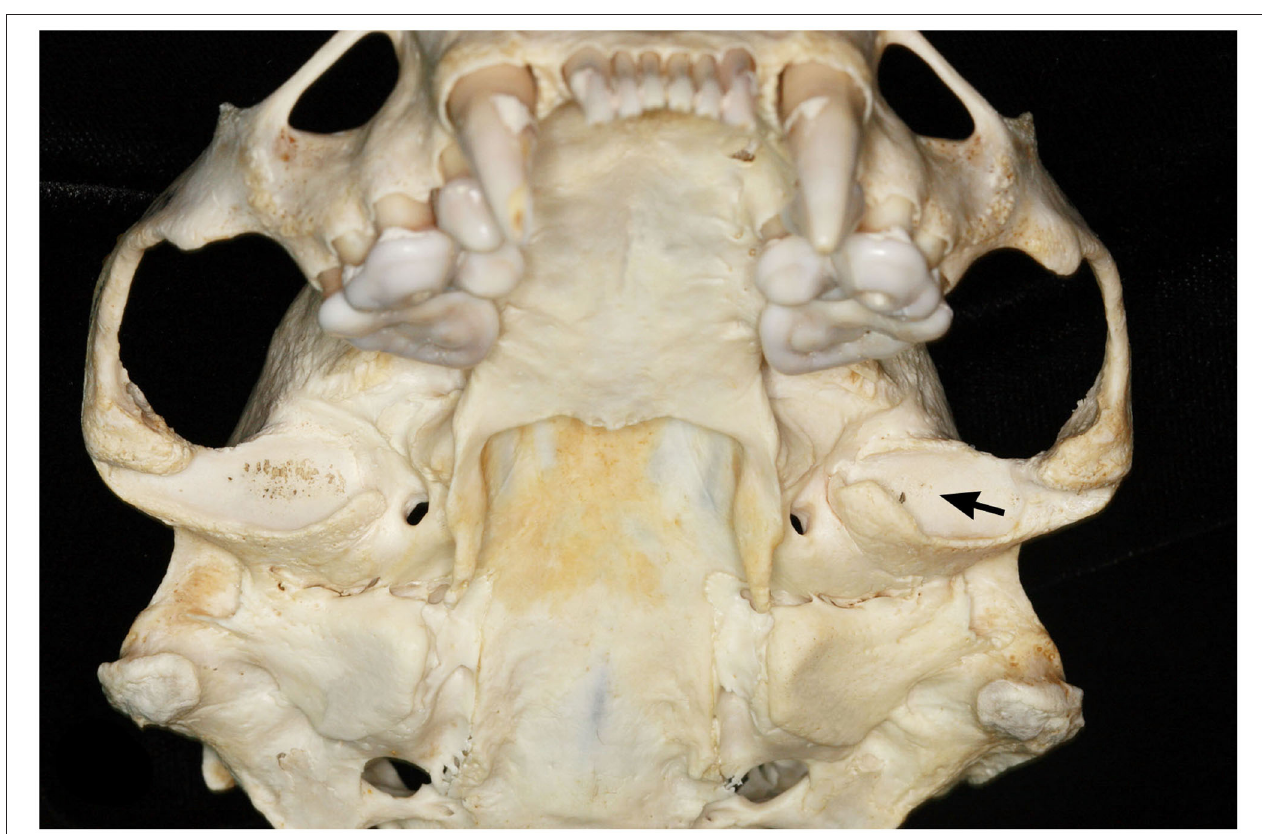
FIGURE 2 | Ventral view of bilateral TMJ-OA of a female southern sea otter ( Enhydra lutris nereis ). The left mandibular fossa has mild OA as evidenced by mild subchondral bone erosion (arrow). The right mandibular fossa has severe OA as evidenced by more pronounced subchondral bone erosion and